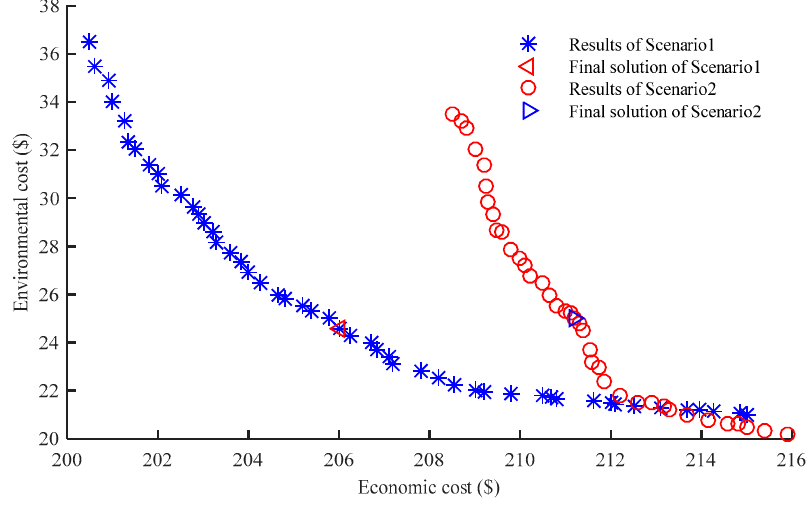
Figure 11. Results of Scenarios 1 and 2.